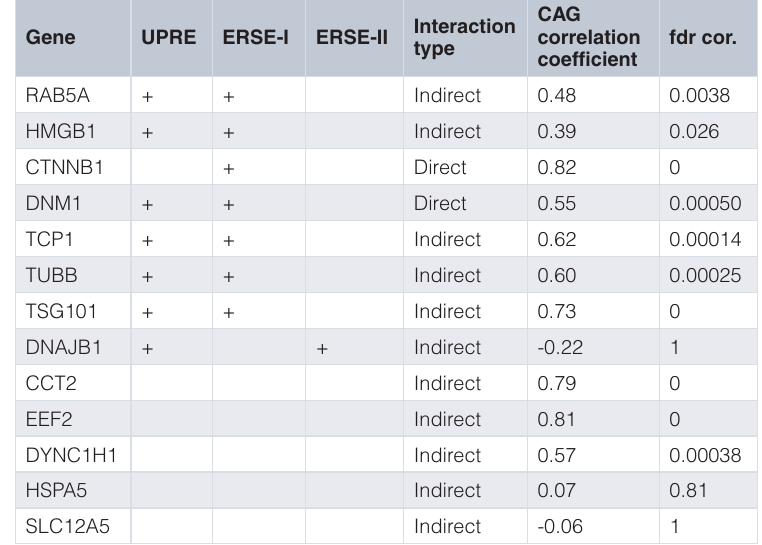
Table 3. Differentially regulated UPR genes that interact with HTT and were classified as potential HD therapeutic targets (HDTT). + indicates the presence of ER stress-associated sequence motifs (UPRE, ERSE-I, ERSE-II) in the promoter regions (+1000 to -500 bp). Interaction type indicates whether the protein was shown to have a direct or indirect physical interaction. The Spearman correlation coefficient and the corresponding estimated fdr describe the correlation of gene expression with the length of polyglutamine tract in HD